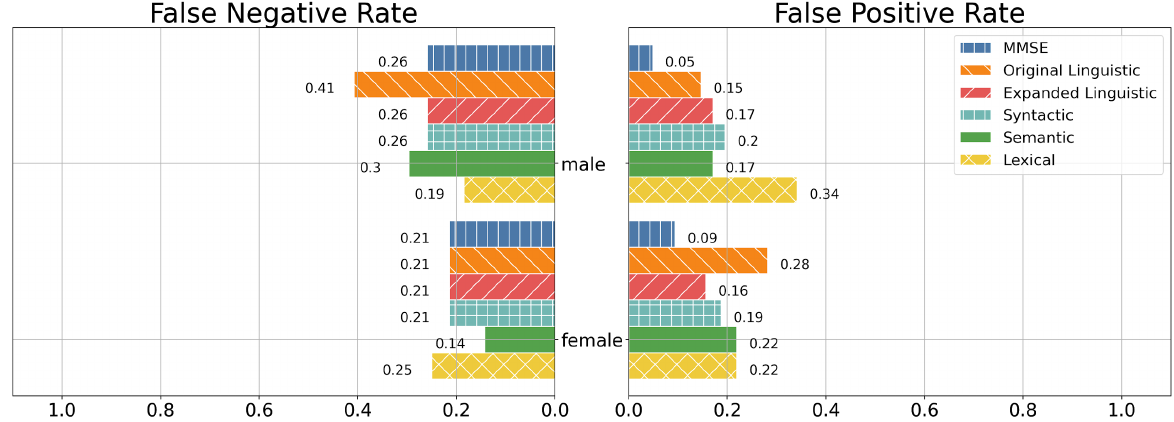
Per Figure 3, MMSE and the baseline linguistic feature set had lower FPRs on male participants than on female participants while the expanded linguistic feature set had a lower FPR on female participants than on the male participants.